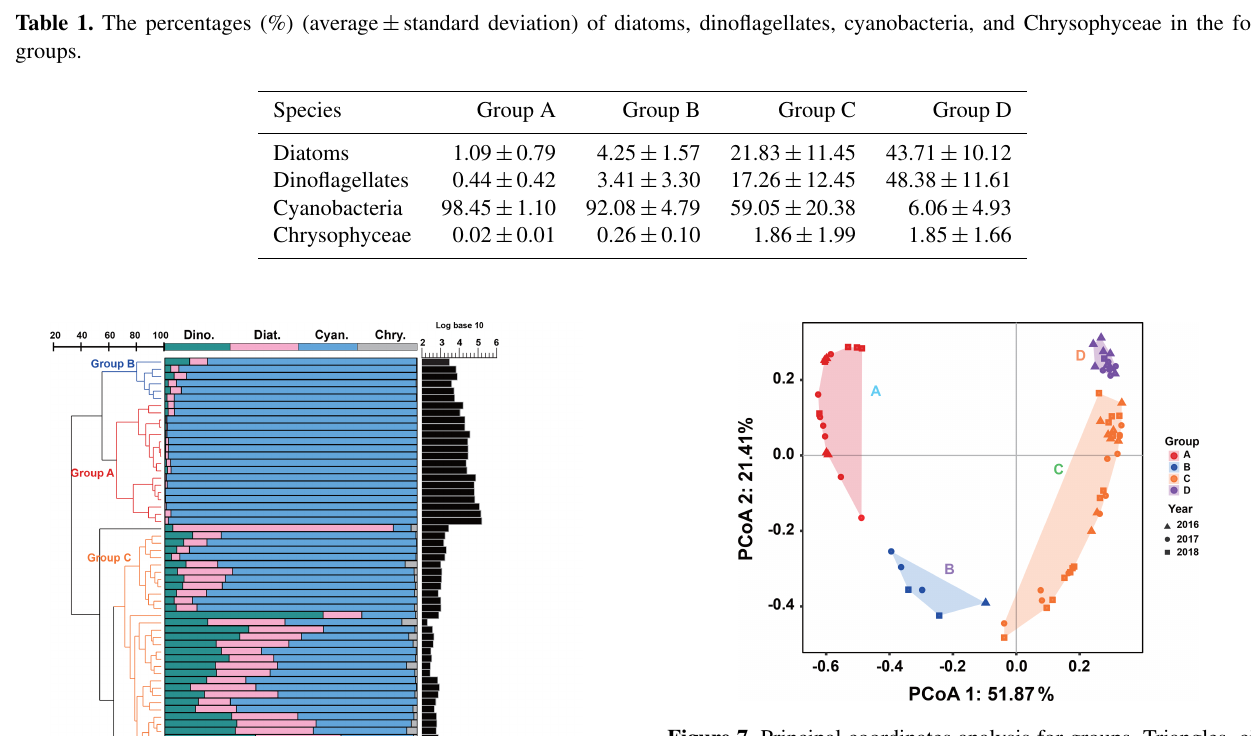
Figure 7. Principal coordinates analysis for groups. Triangles, cir- cles, and squares represent 2016, 2017, and 2018 stations, respec- tively. P < 0 . 05. Different colors represent different groups. Per- centages of total variance are explained by coordinates 1 and 2, ac- counting for 51.87% and 21.41%,